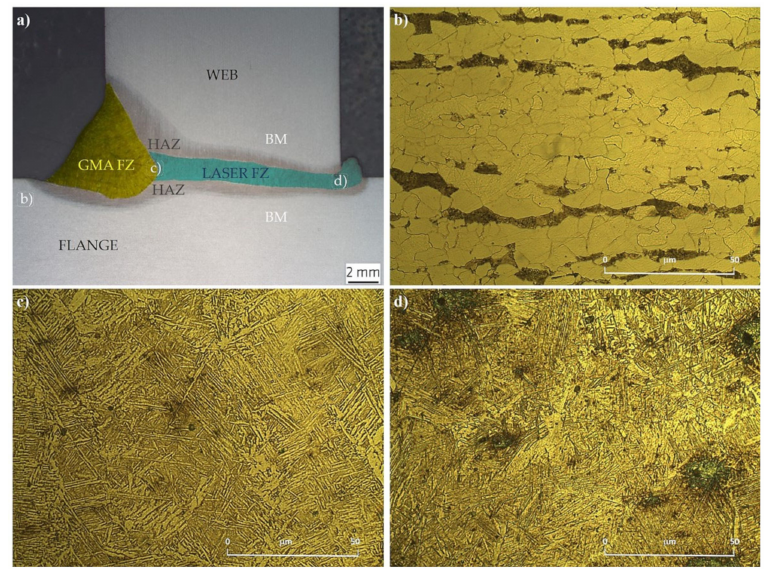
Figure 7. Optical metallographic images of cross-sections of the HLAW F sample ( a ) image at 20 × with fusion zones highlighted (arc in yellow and laser in blue); ( b ) image of base metal at 1000 × ; ( c ) image of GMA fusion zone at 1000 × ; ( d ) image of laser fusion zone at 1000 ×